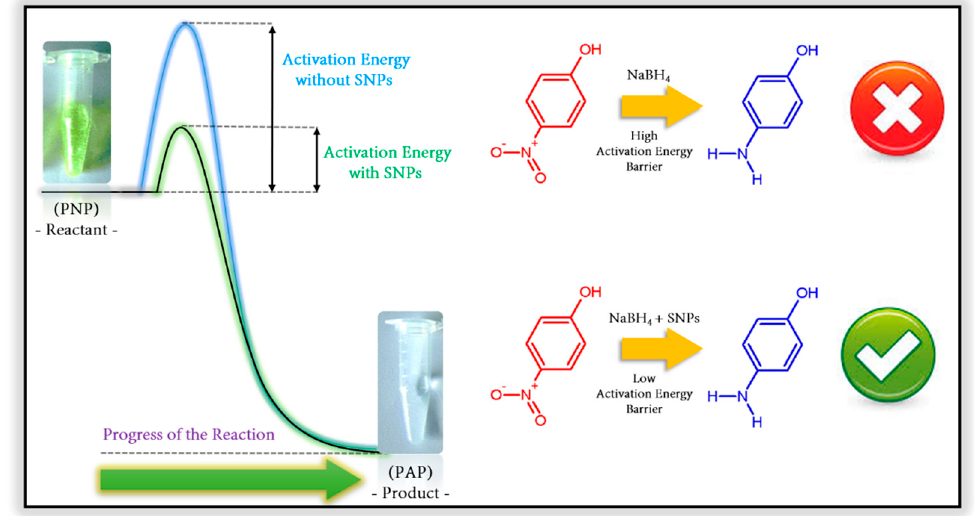
Figure 3. Graphical representation of activation energy and catalytic reduction of PNP to p -aminophenol (PAP).